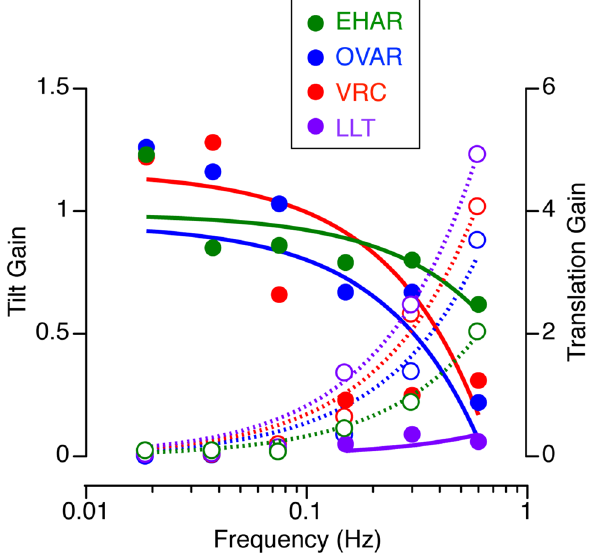
Figure 4. Data from Fig. 3 superimposed in a single diagram. The closed symbols and the solid fit lines show the tilt gains across all motion paradigms. The open symbols and the dashed fit lines show the translation gain across all motion paradigms. Curve fittings are linear curve fits. The crossover frequency between tilt gain and translation gain occurred between 0.15 Hz and 0.6 Hz depending on the motion paradigms.